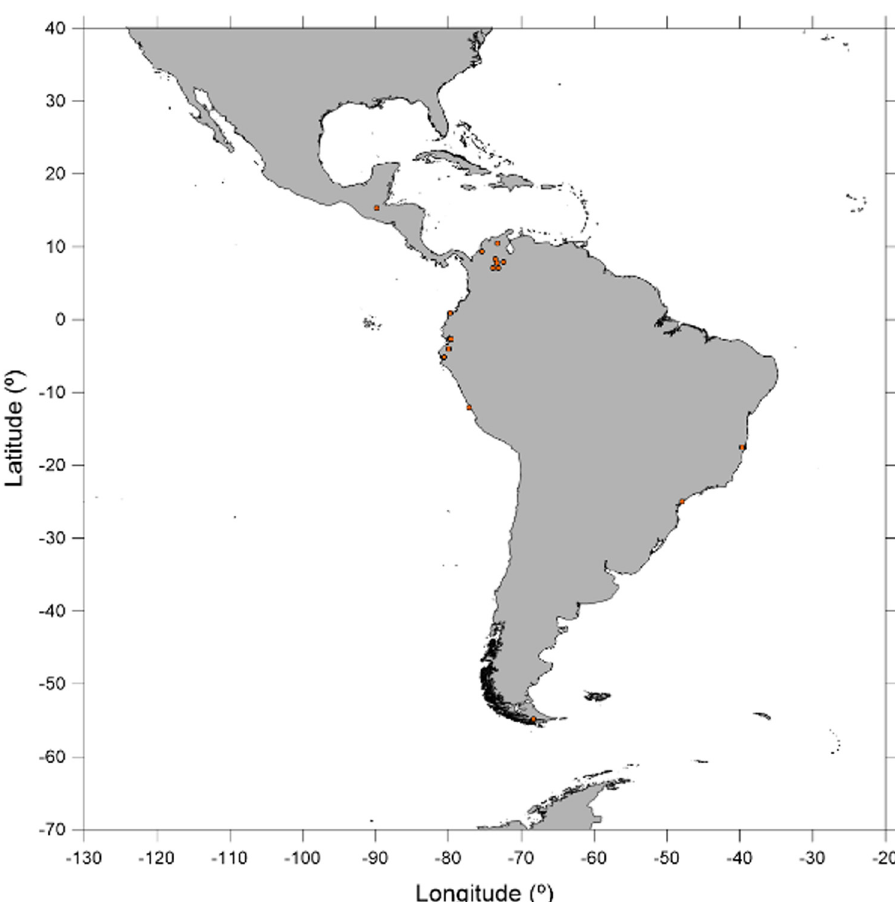
Figure 14: Distribution of SIRGAS - CON stations with some period of discontinuity in the ZTD di ff